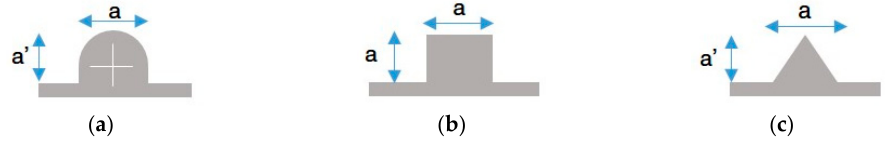
Figure 5. Geometries of the studied reliefs: ( a ) semi-circular, A; ( b ) square, B.; ( c ) triangular, C.